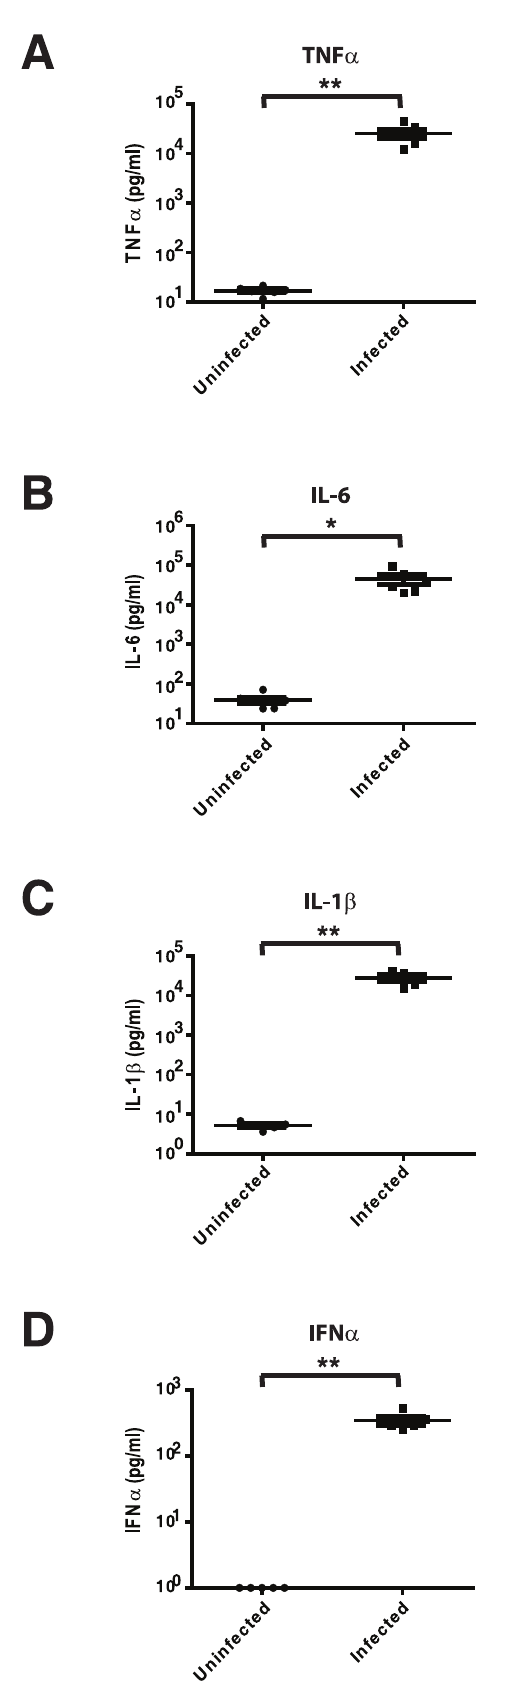
Figure 3. Supernatants from gonococcal-infected PBMCs contain both HIV-1 replication stimulating proinflammatory cytokines and HIV-1 replication inhibiting IFN a . HIV-1-negative PBMCs were infected with N. gonorrhoeae at a MOI of 10 for 24 hours and the levels of TNF a (A), IL-6 (B), IL-1 b (C) or IFN a (D) were quantified by ELISA. (A–D) represent the mean 6 s.e.m. of the cytokine level from the supernatants from 6 separate PBMC donors. Significant differences are represented by comparison with the following legend: *p # 0.05, **p #